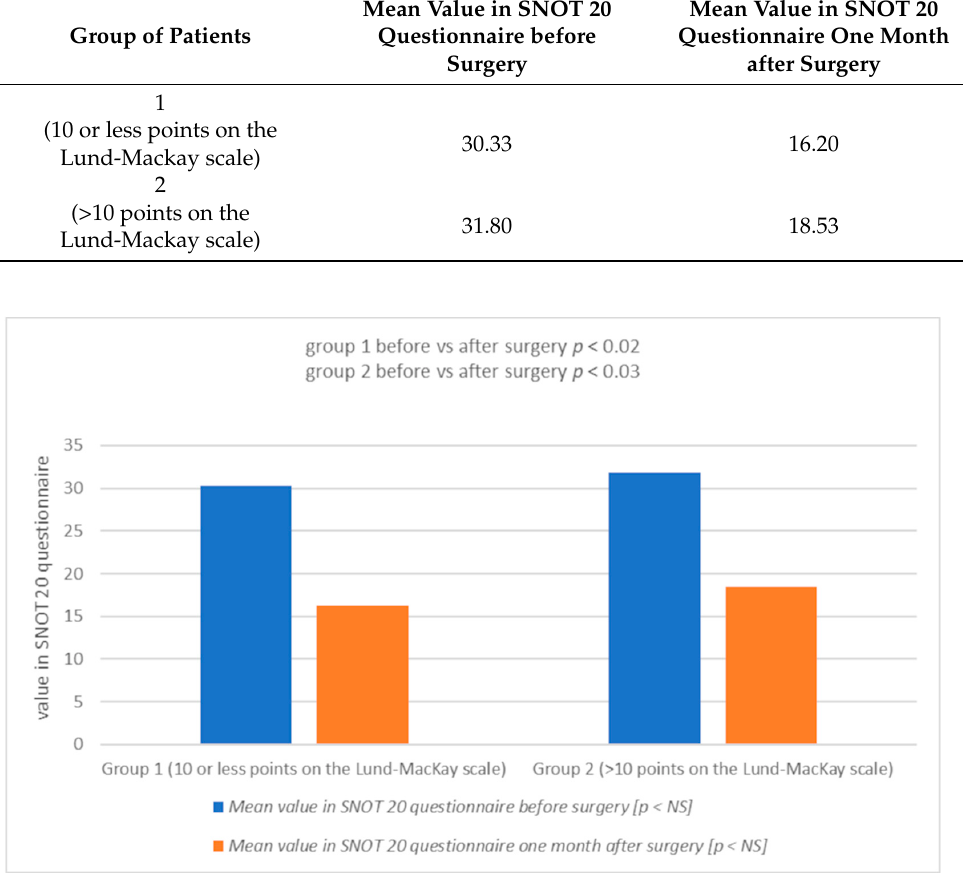
Figure 3. Mean value in the Sinonasal Outcome Test SNOT 20 questionnaire before and one month after surgery in group 1 and 2 (graph; NS: not